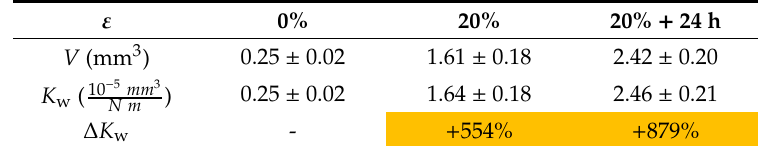
Table 3. Test results on the wear of deformed polymer (working with steel, tension, parallel direction,